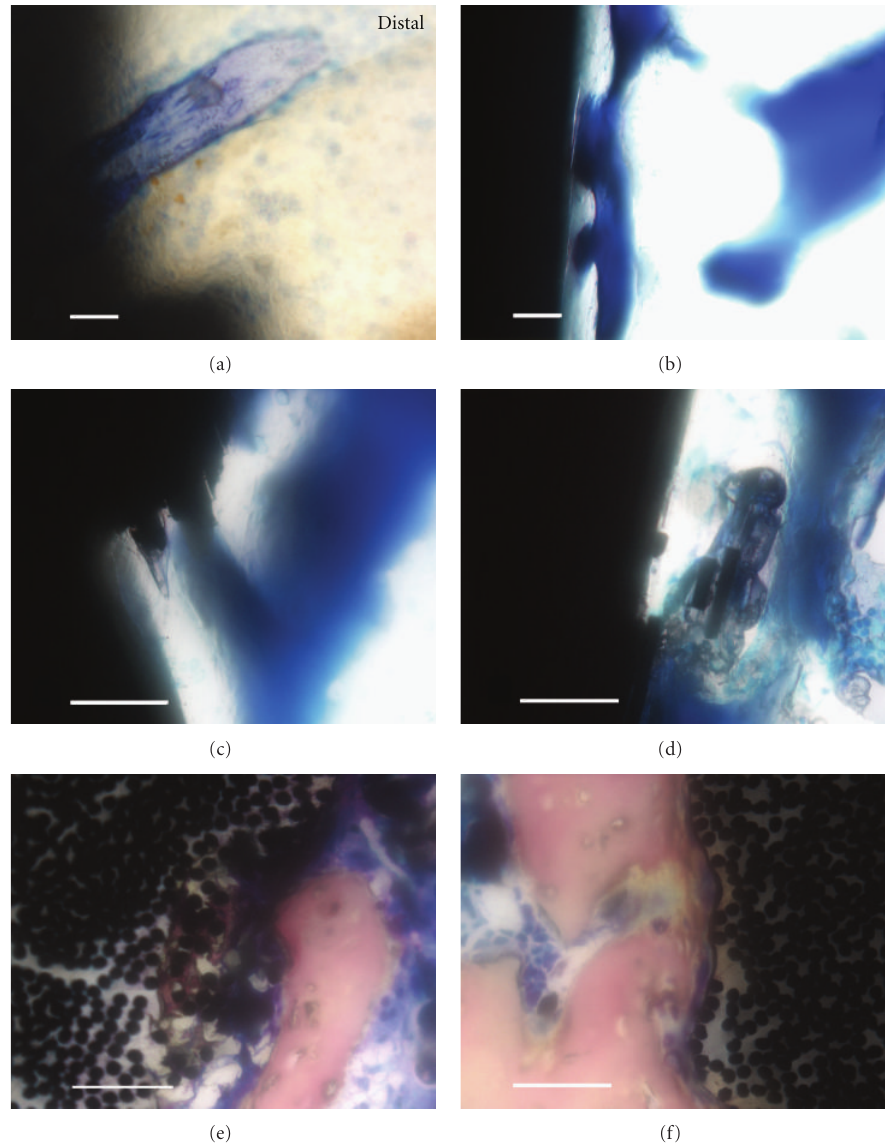
Figure 5: Histological high-magnification imaging with all scale bars approximately 50 μ m. (a) Lateral section of the titanium-6-4 alloy image from Figure 4(a) on distal reveals some implant/bone particle integration using toluidine blue stain. (b) Lateral section of a bisphenyl- polymer/carbon-fiber implant exhibits a typical osseointegrated interface with a sophisticated pore-architecture remodeling that may have contained more in vivo osteoid using toluidine blue. (c) Lateral section of a bisphenyl-polymer/carbon-fiber implant presents a fractured composite surface that appears to stimulate bone directly onto an area that represents 2 multiple fiber-fracture ends with toluidine blue. (d) Lateral section of a bisphenyl-polymer/carbon-fiber implant shows an osseointegrating interface with multiple fractured fiber-fragment pieces debonded from the composite and encased in bone with toluidine blue. (e) Horizontal section of a bisphenyl-polymer/carbon-fiber composite implant not included in the statistical analysis expresses calcifications as intense bone integration into the implant surrounding individual carbon fibers of approximate 7 μ m diameter after removing portions of the polymer matrix utilizing Sanderson’s stain. The surface defect is approximately 200 μ m deeply. (f) Horizontal section of a bisphenyl-polymer/carbon-fiber composite implant also not included in the statistical analysis shows fibers being pulled away from the implant at the bone interface that would necessarily entail polymer degradation or softening, using Sanderson’s